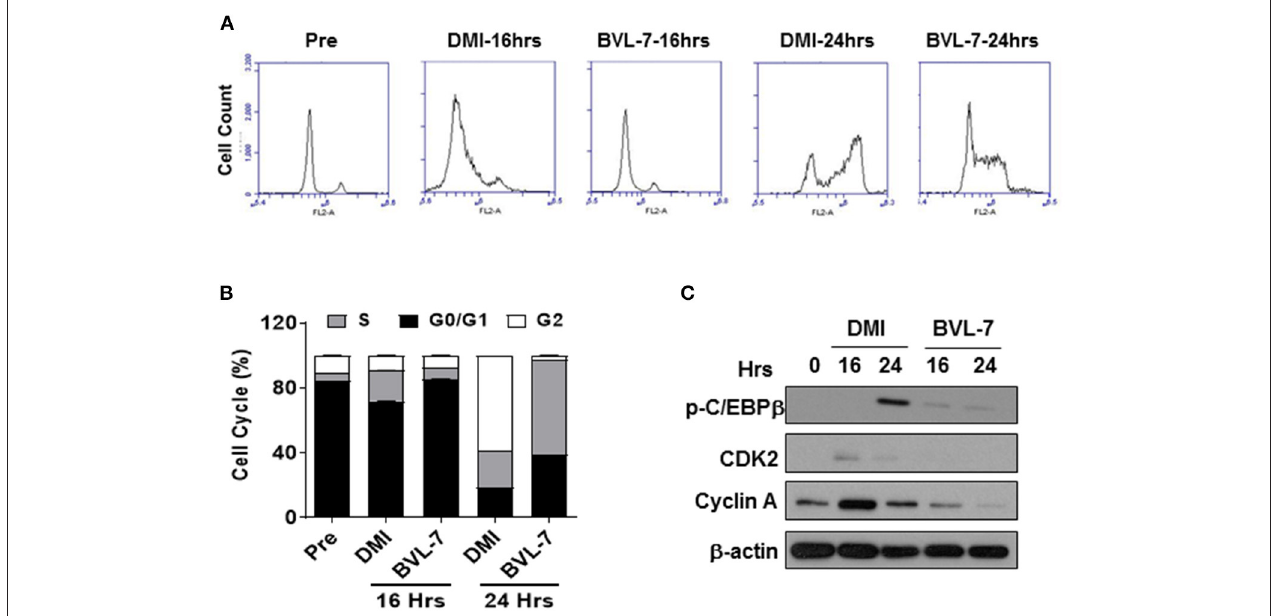
FIGURE 4 | BVL-7 suppresses mitotic clonal expansion in the early stage of differentiation. (A) The cell cycle analysis was performed by flow cytometry and (B) the distribution of each phase in the cell cycle was shown. (C) The protein levels of cell cycle regulators were measured, and the representative image was shown. The values were presented using mean ± SEM ( n =